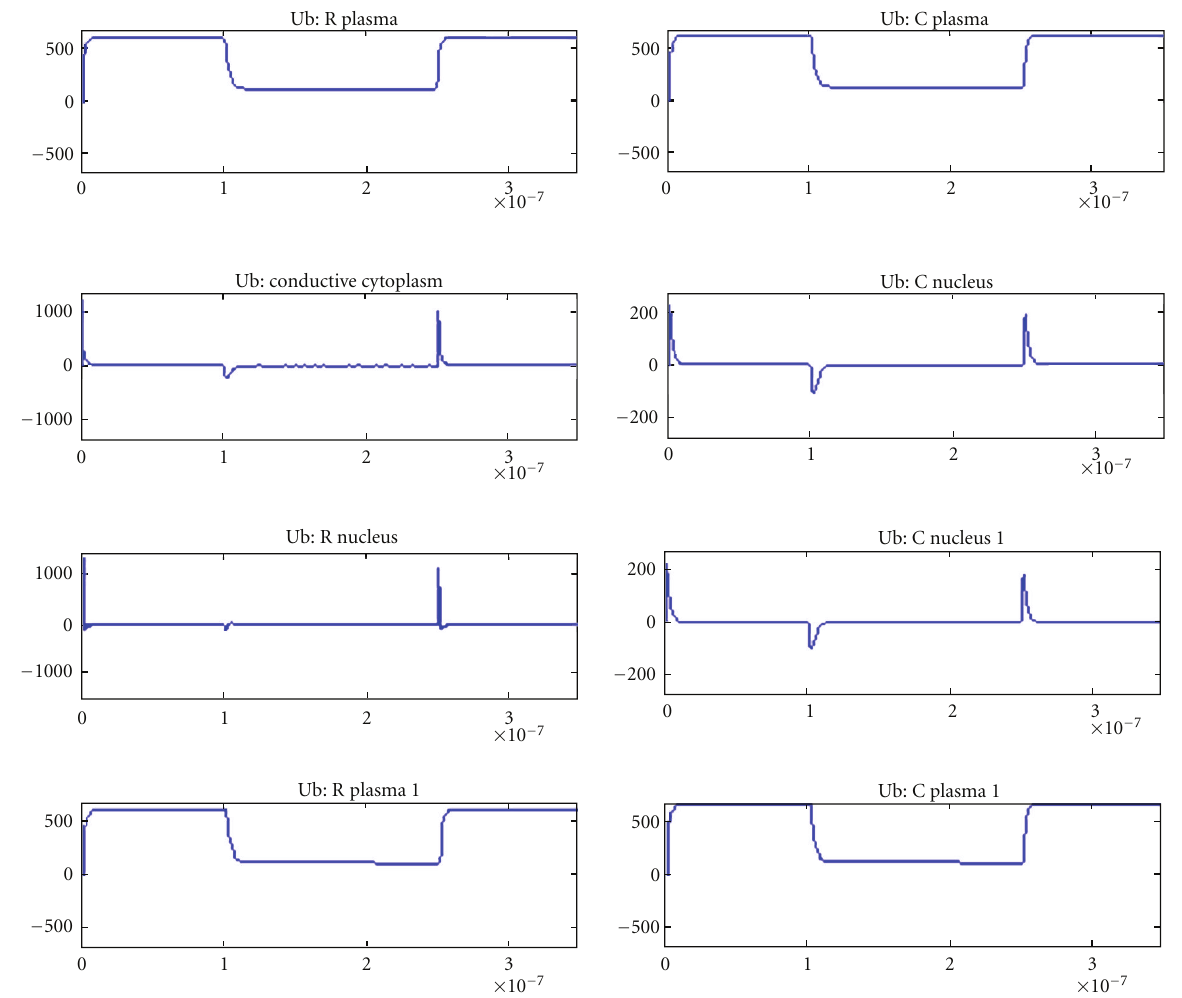
Figure 9: Voltage across various cell elements in tissue with tumor cells (needle electrode configuration).